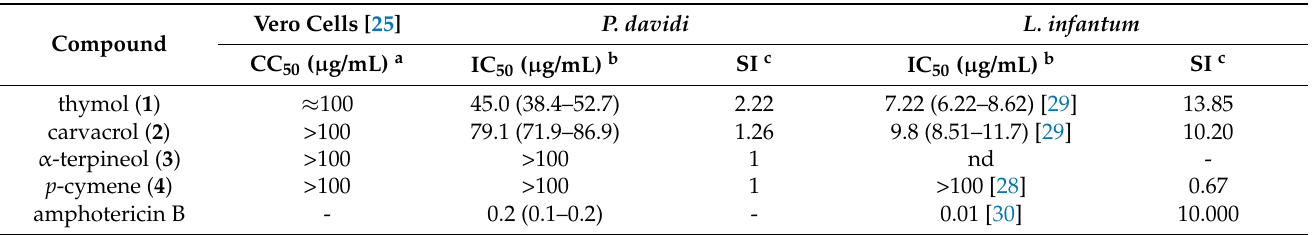
Table 4. Effects of the tested compounds on P. davidi, L. infantum , and Vero cells (IC 50 and CC 50